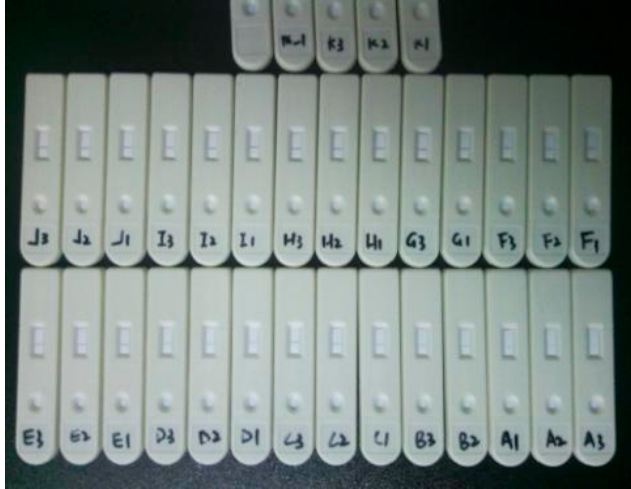
Figure 7. Test strips for colloidal gold-based ICG assay.